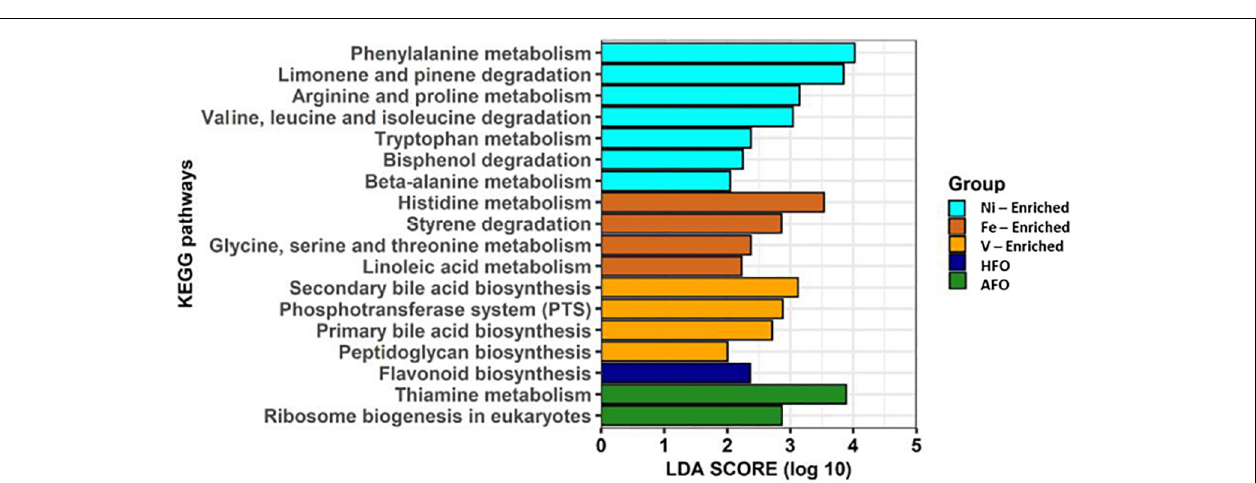
FIGURE 5 | Predicted functional features of 16S rRNA metagenomic data using Picrust2. Abbreviations: ACO, Australian crude oil; HFO, heavy fuel